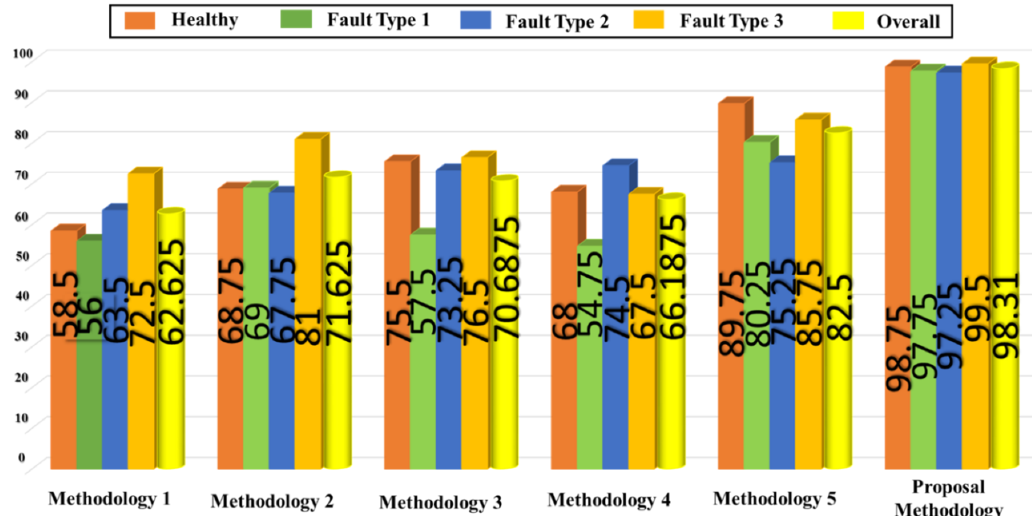
Figure 14. The accuracy of each class and the average accuracy of the state-of-the-art methodologies and the proposed ANR-GRS methodology.